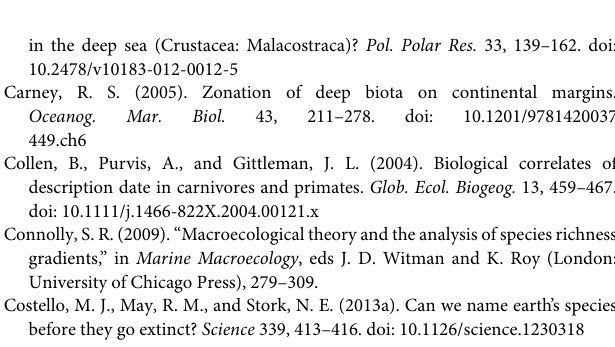
Figure S1 | Species latitudinal range midpoints plotted against year described, for the northern and southern hemispheres. Red lines show line of best fit for data in each